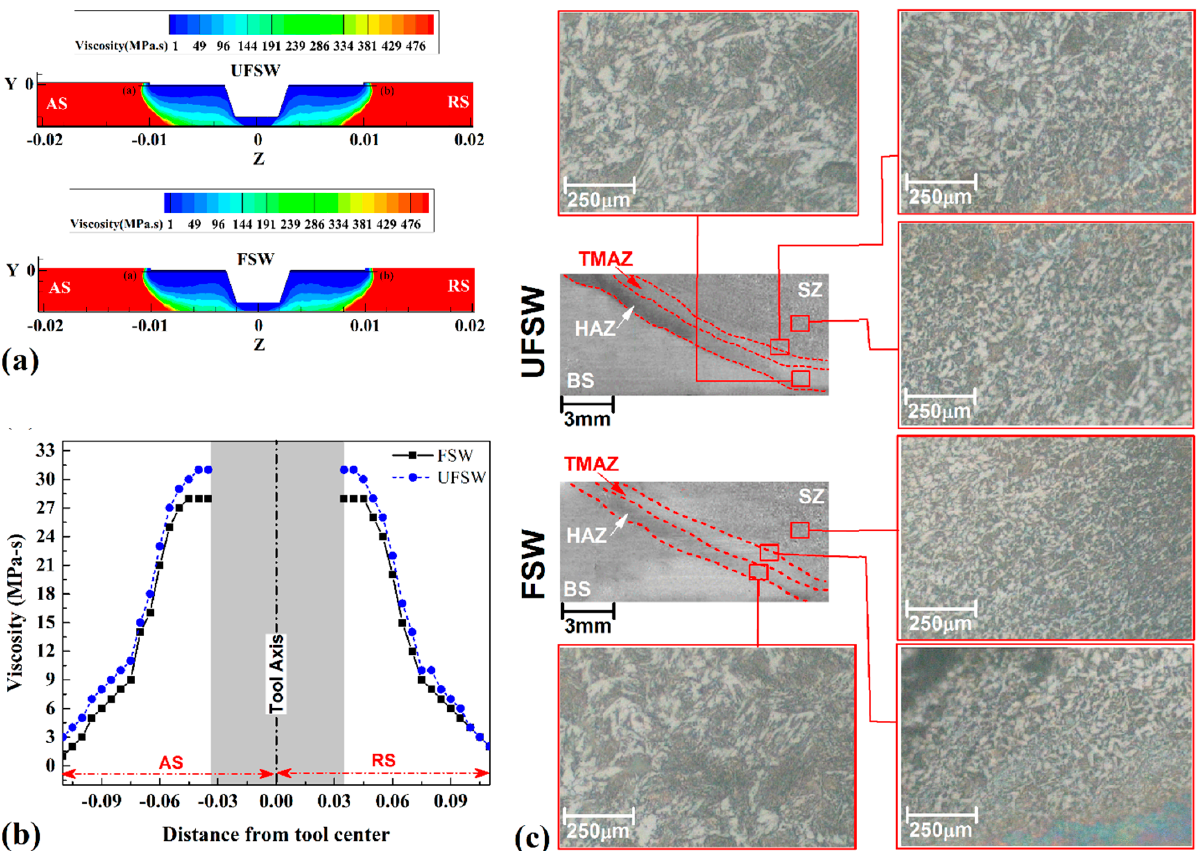
Figure 7. ( a ) Results of viscosity variations from simulation in welded samples. ( b ) Numerical analysis of viscosity changes along line ( a , b ) and ( c ) microstructure of welded joints.